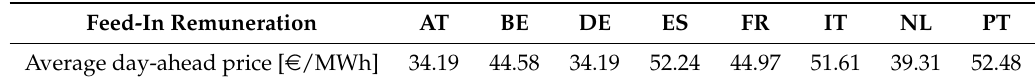
Table A1. Day-Ahead prices for target countries in